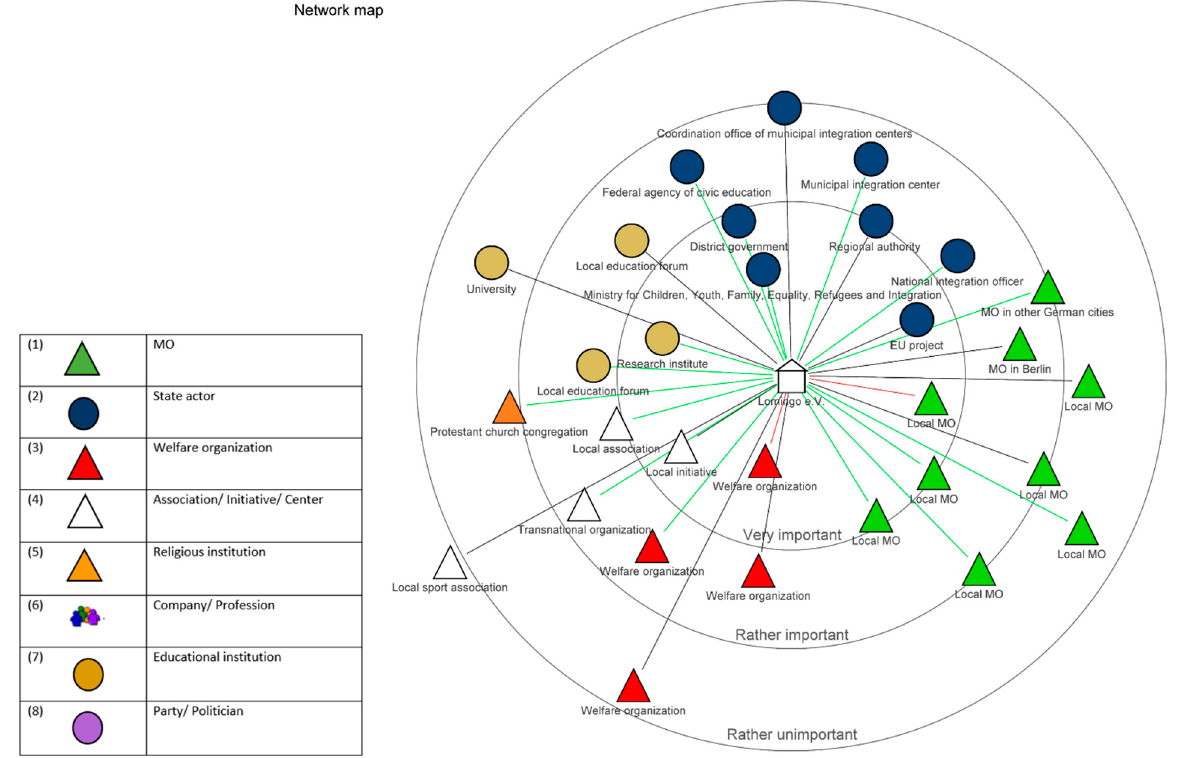
Figure 1. Example of a network map, in this case for the MO Lomingo e.V.